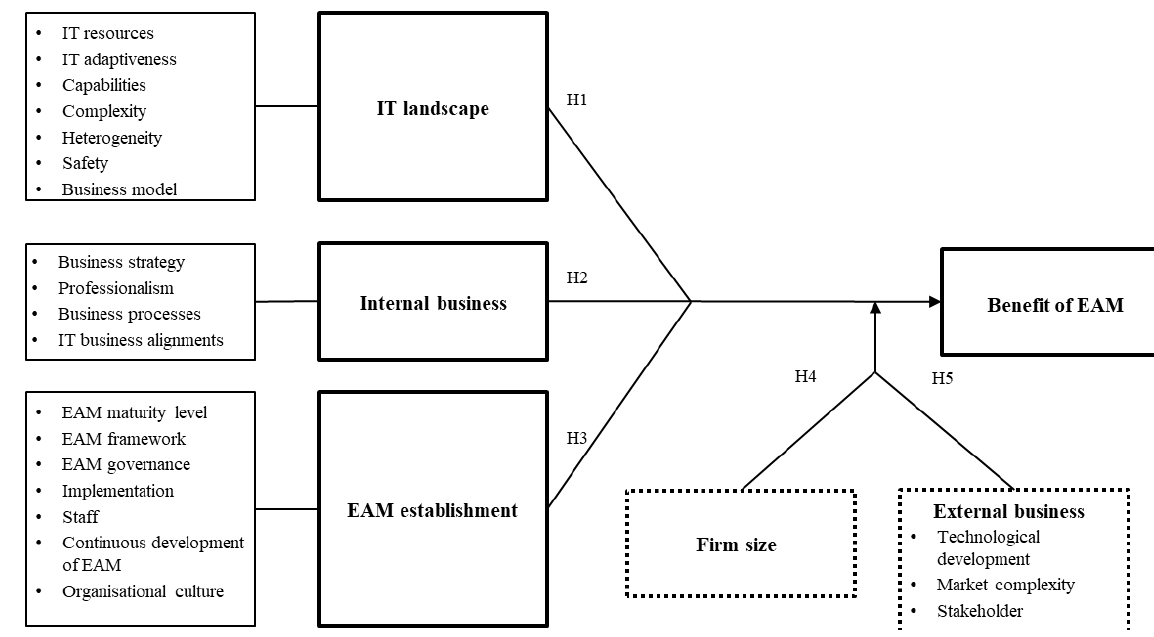
Figure 2. Revised Research Model based on Reichstein et al. 2019 [1]